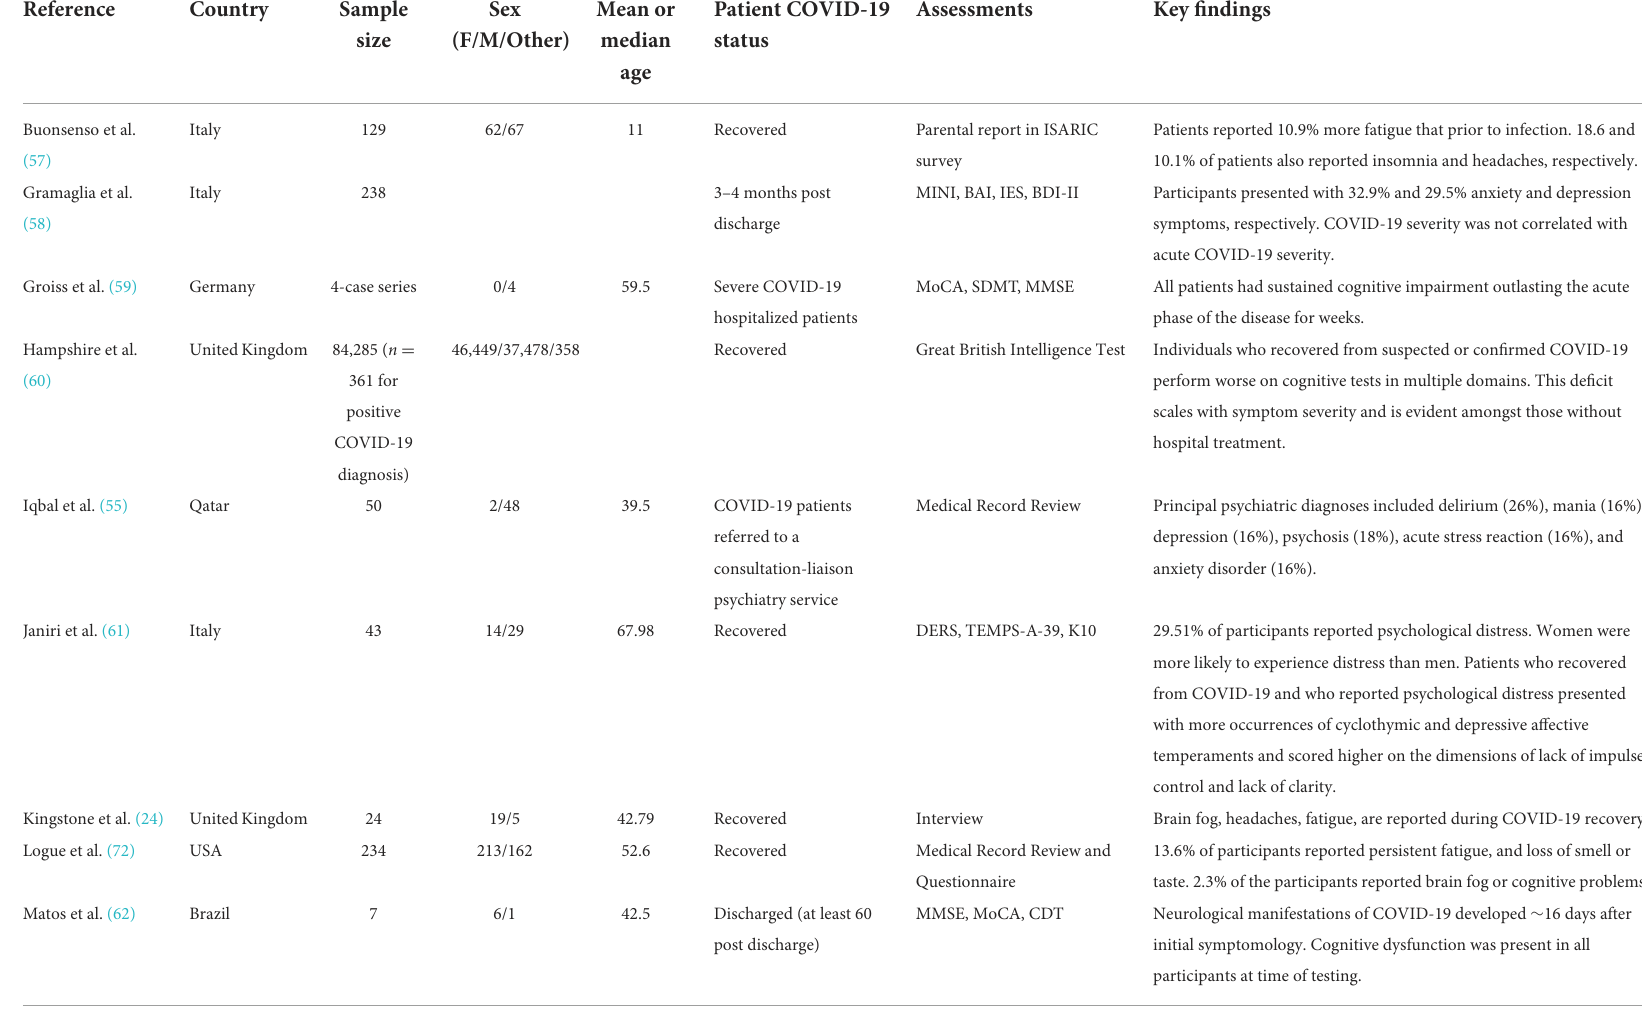
TABLE 2 Studies investigating chronic neuropsychiatric